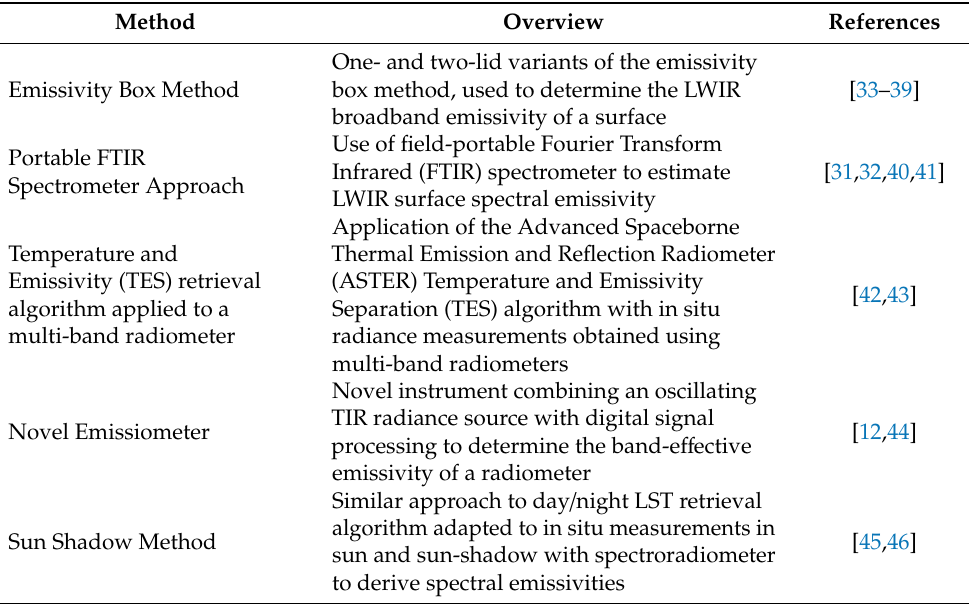
Table 1. Overview of various di ff erent field emissivity measurement techniques, with variants of the first approaches considered in this